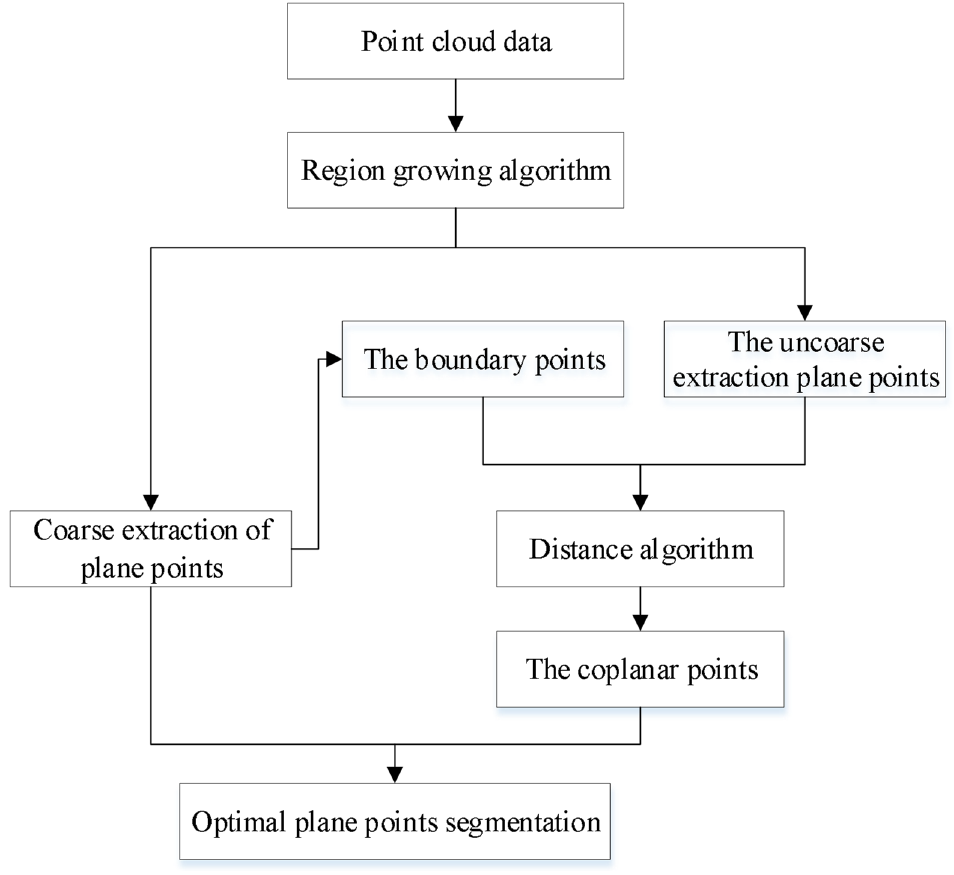
Figure 1. Workflow of building plane point segmentation.